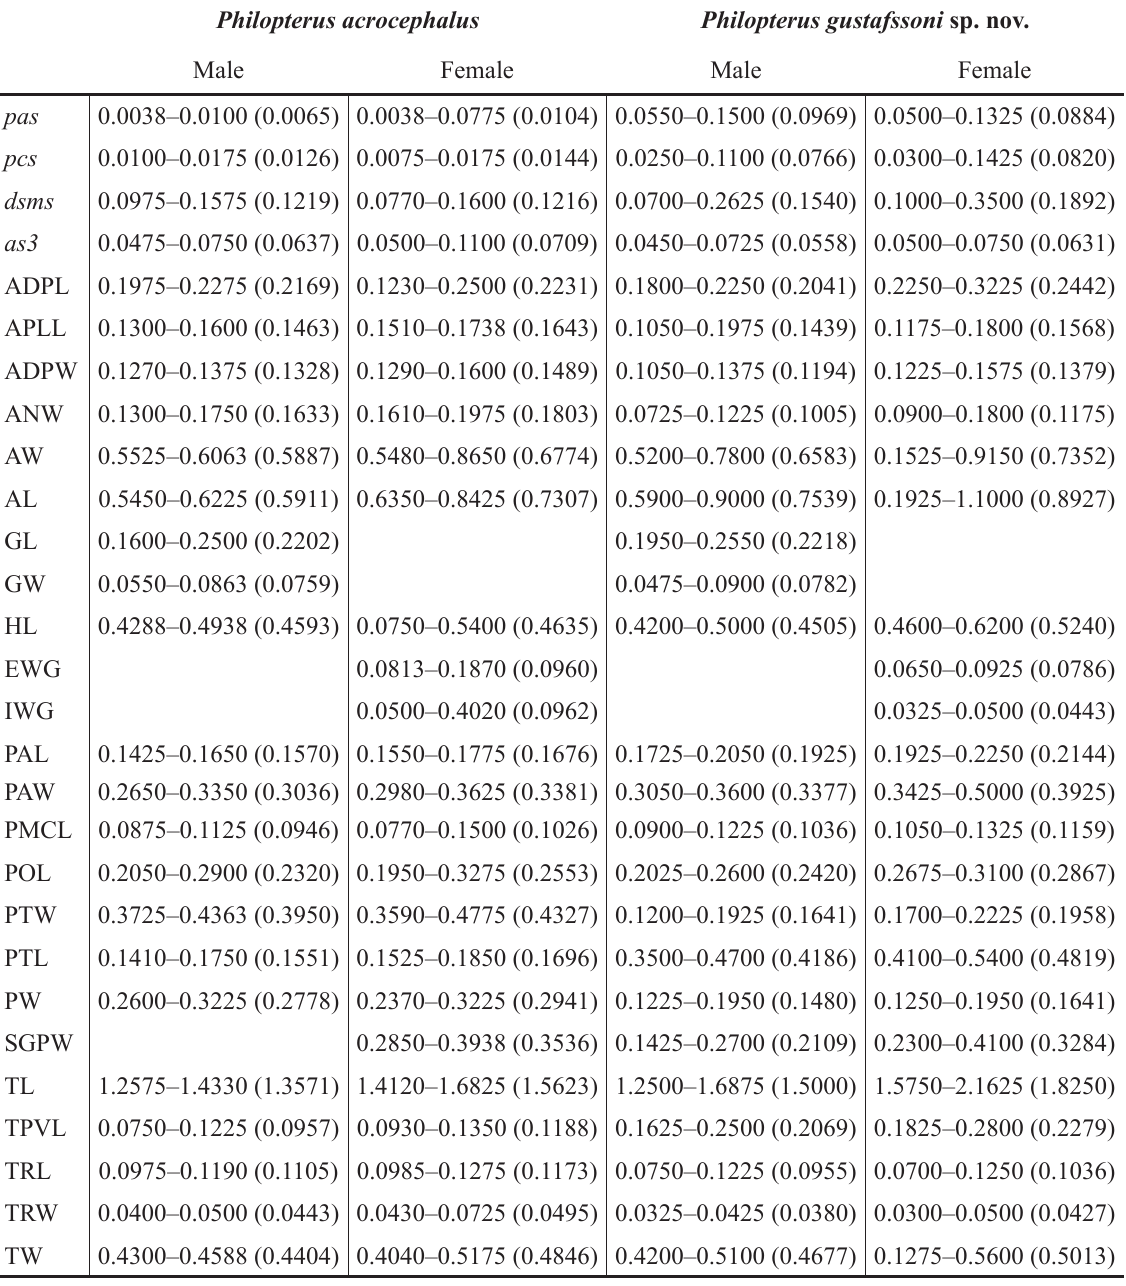
Table 3. Measurements of Philopterus acrocephalus Carriker, 1949 and Philopterus gustafssoni sp. nov. Ranges with mean values in parentheses. Abbreviations: pas – preantennal seta; pcs – preconal seta; dsms – dorsal submarginal seta; as3 – third anterior seta; ADPL – anterior dorsal plate length; APLL – anterior dorsal plate lateral length; ADPW – anterior dorsal plate width; ANW – anterior notch width; AW – maximal width of abdomen; AL – length of abdomen; GL – male genitalia length; GW – male genitalia width; HL – head length; EWG – external width of genital chamber; IWG – internal width of genital chamber; PAL – preantennal length; PAW – preantennal width; PMCL – premarginal